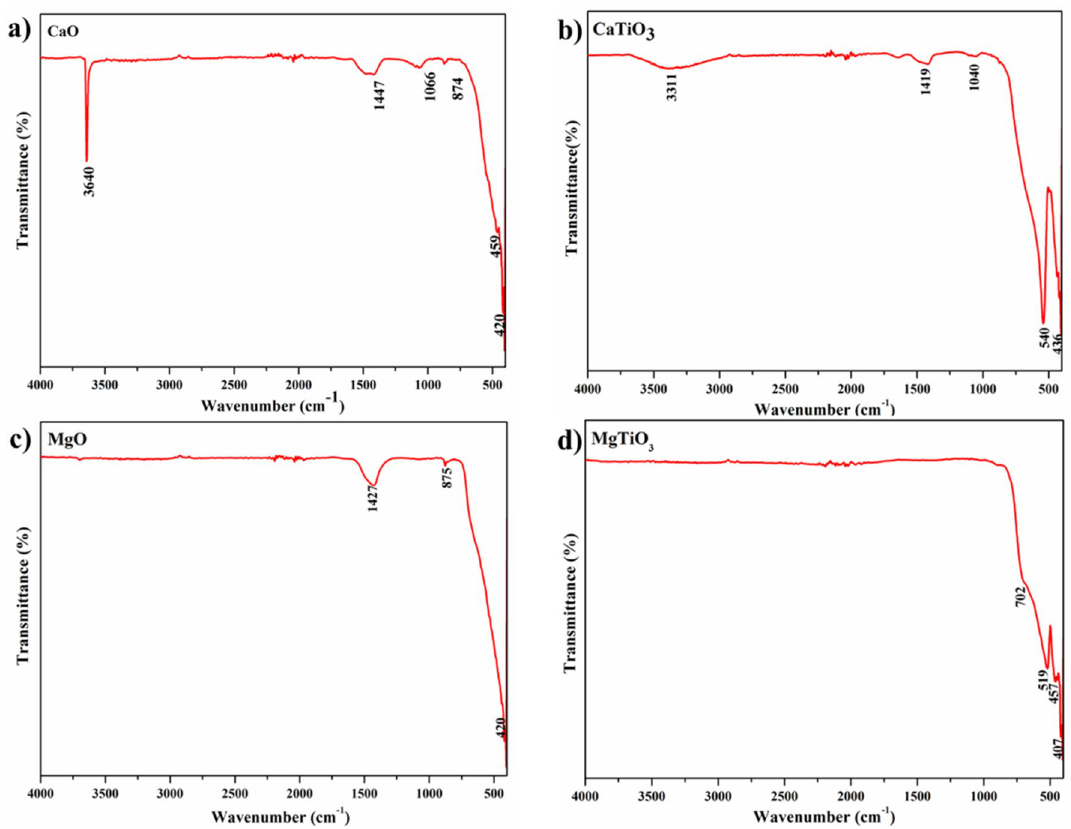
Figure 1. FT-IR spectra of ( a ) CaO, ( b ) CaTiO 3 , ( c ) MgO and ( d ) MgTiO 3